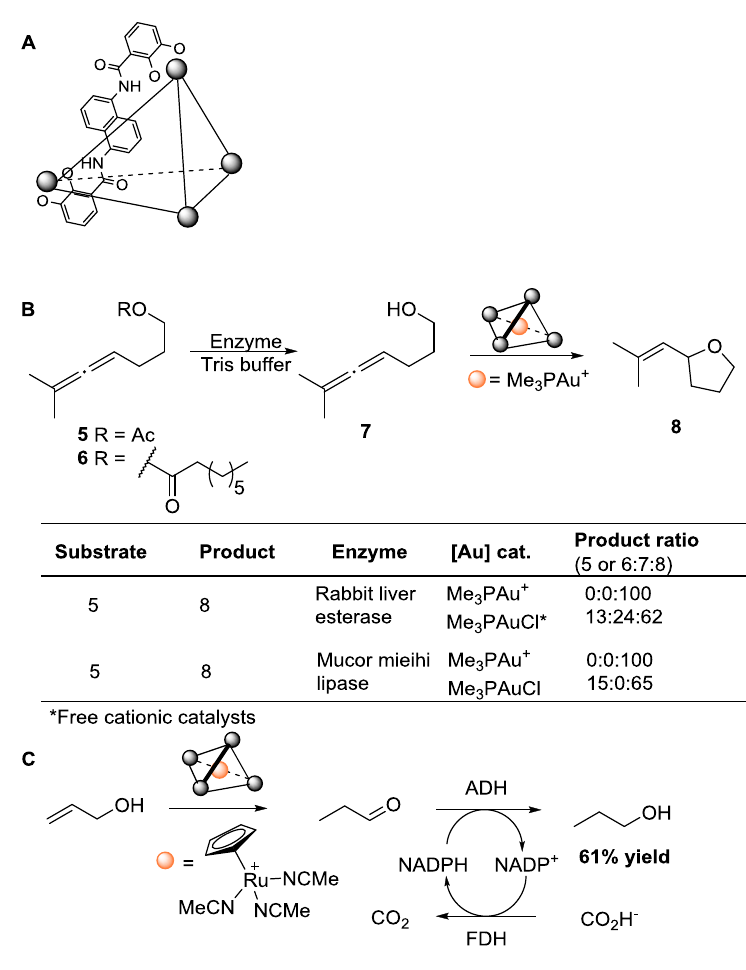
Scheme 7. A schematic view of the Ga 4 L 6 tetrahedral supramolecular assembly ( A ) in which each edge of the tetrahedron represents a bisbidentate ligand and each vertex represents a gallium center (grey balls); ( B ) and ( C ) are metal catalysts encapsulated within a supramolecular complex in tandem with biocatalysts. ADH, alcohol dehydrogenase; FDH, formaldehyde dehydrogenase. Reprinted by permission from Macmillan Publishers Ltd: Nature Chemistry [62]. Copyright 2013.